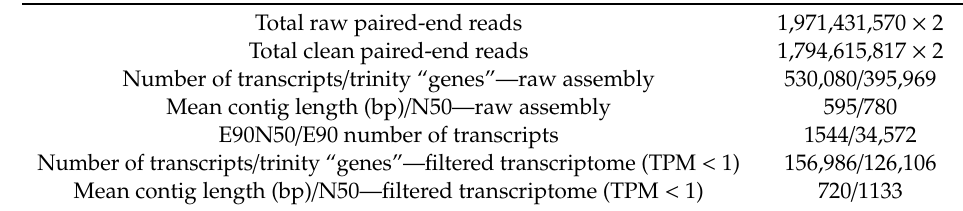
Table 1. Summary of RNA-Seq and genome-guided sequence assemblies (raw and filtered) of Q. pubescens. TPM (Transcripts Per Kilobase Million).